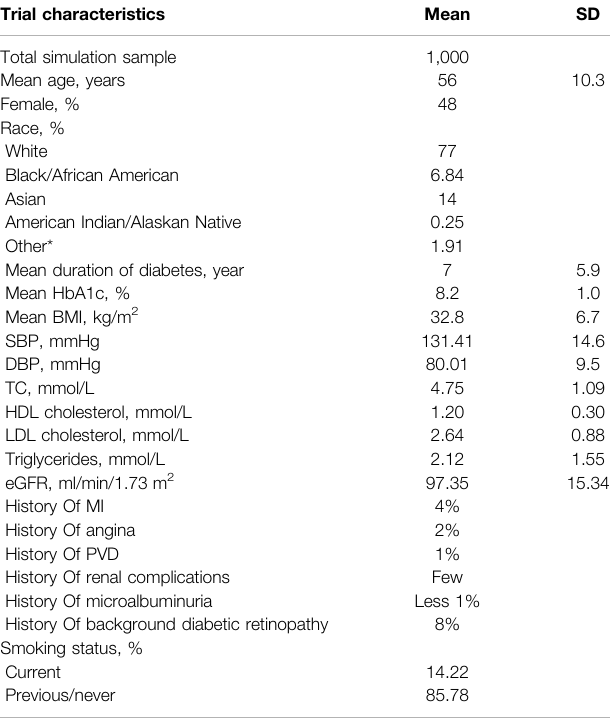
TABLE 1 | Baseline characteristics of simulation cohort.